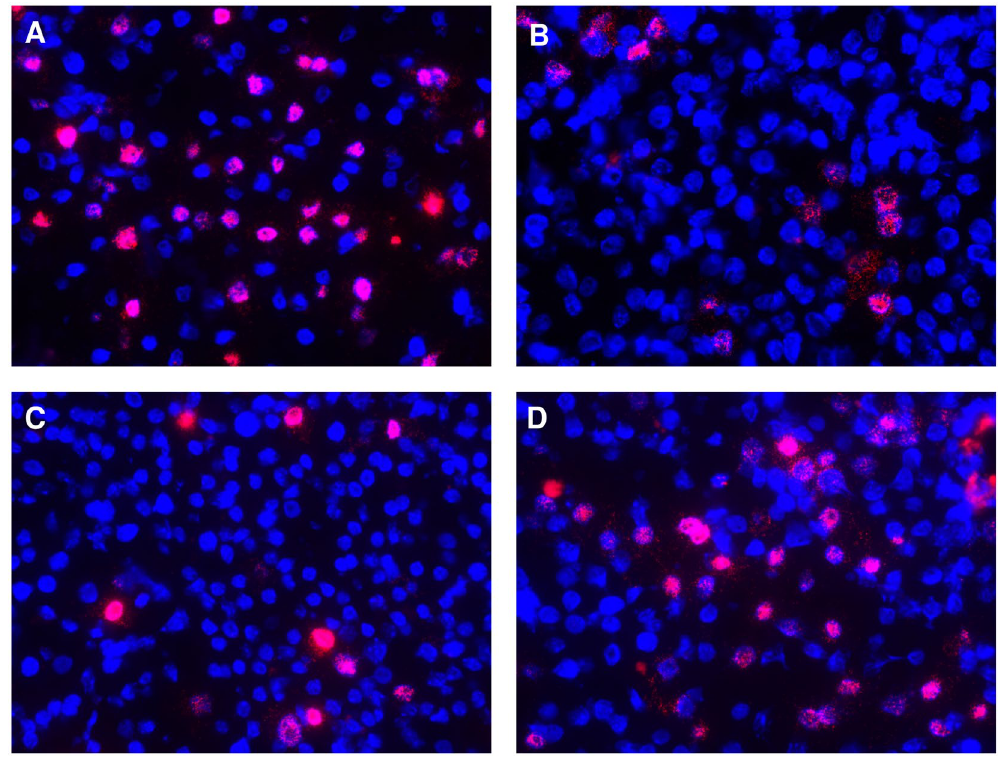
Figure 5. Antigenomic HDV RNA determined by an RNA in situ hybridisation assay (RNAScope). Immunofluorescence staining of both antigenomic HDV RNA and HDV mRNA (red dots) in humanized liver specimen of untreated control mice ( A ) and mice either treated with peg-INF α ( B ), peg-INF λ ( C ) or ETV ( D ). Nuclei are stained in dark blue (Hoechst